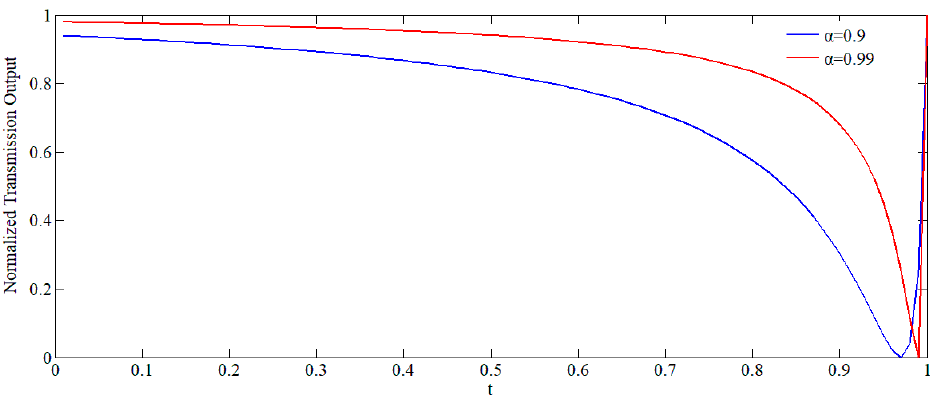
Figure 7. The universal transmission plot for the configuration in Figure 5.